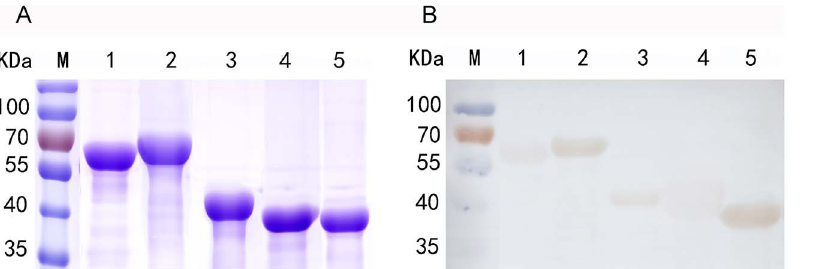
Figure 3. Immunoblotting analysis of surface-exposed proteins. (A) Five recombinant SEPs purified from E. coli cell lysate were separated by 12% SDS-PAGE and stained by G-250 Coomassie Brilliant Blue. (B) Immunoblotting analysis of SEPs: lane M, protein molecular mass markers; lanes 1 to 5, rTolC, rPorin_4, rAdr1, rOmpW, and rAdr2.